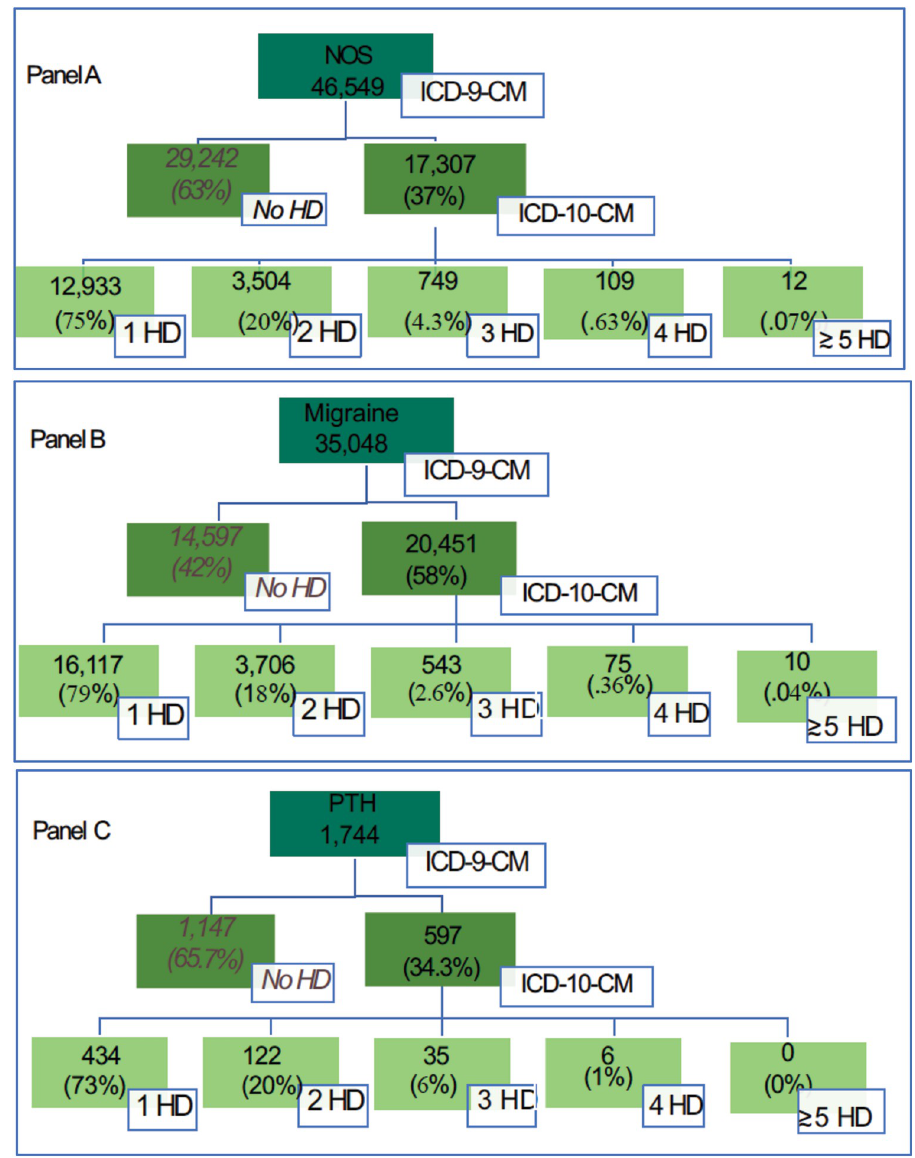
Fig 1. Distribution of patients based on number of headache diagnoses in ICD-10-CM. Abbreviations: Not- otherwise-specified (NOS); International Classification of Diseases, 10 th edition, Clinical Modification (ICD-10-CM); Headache Diagnoses (HD); Post-Traumatic Headache